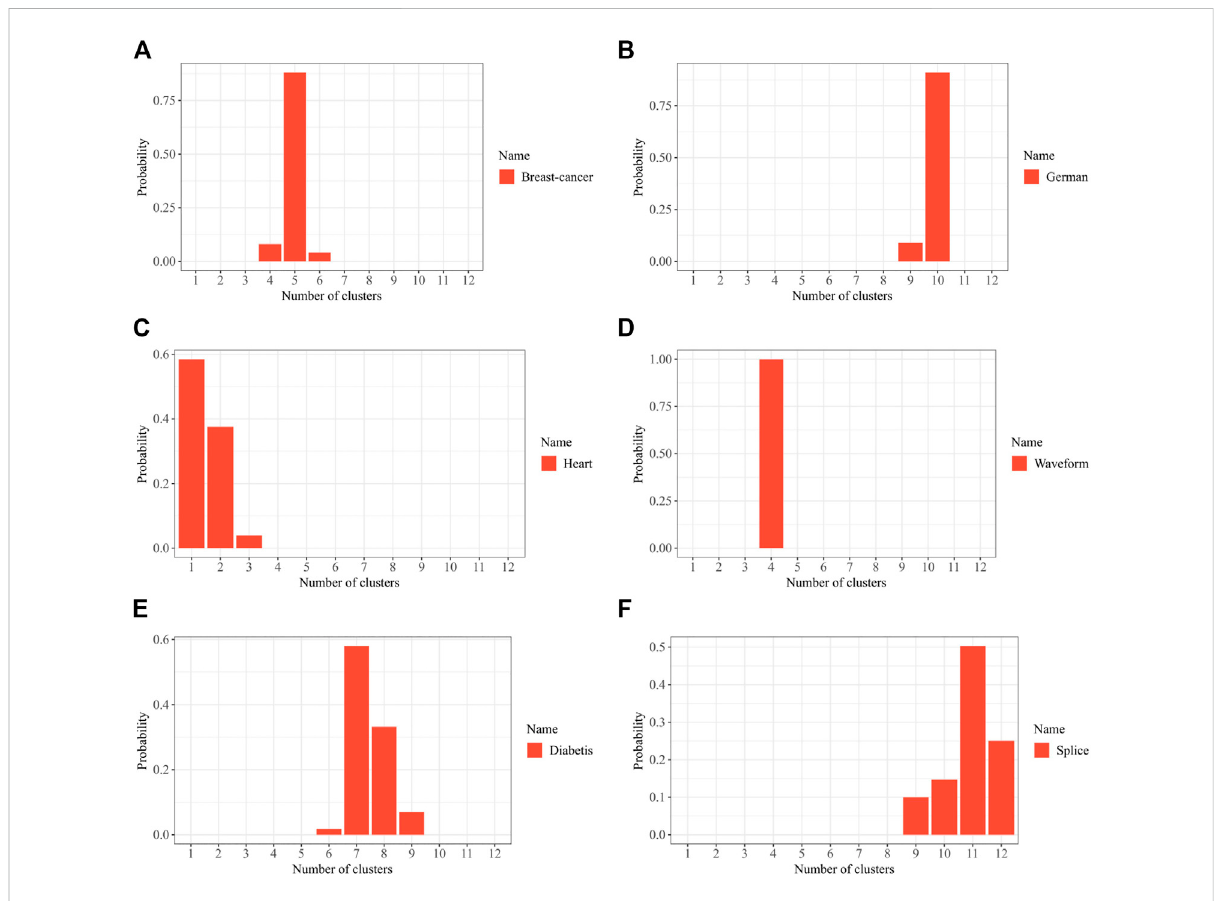
FIGURE 4 Approximate posterior distribution on the number of clusters by dpMMSPFA (A) Breast-cancer; (B) German; (C) Heart; (D) Waveform; (E) Diabetis; (F)